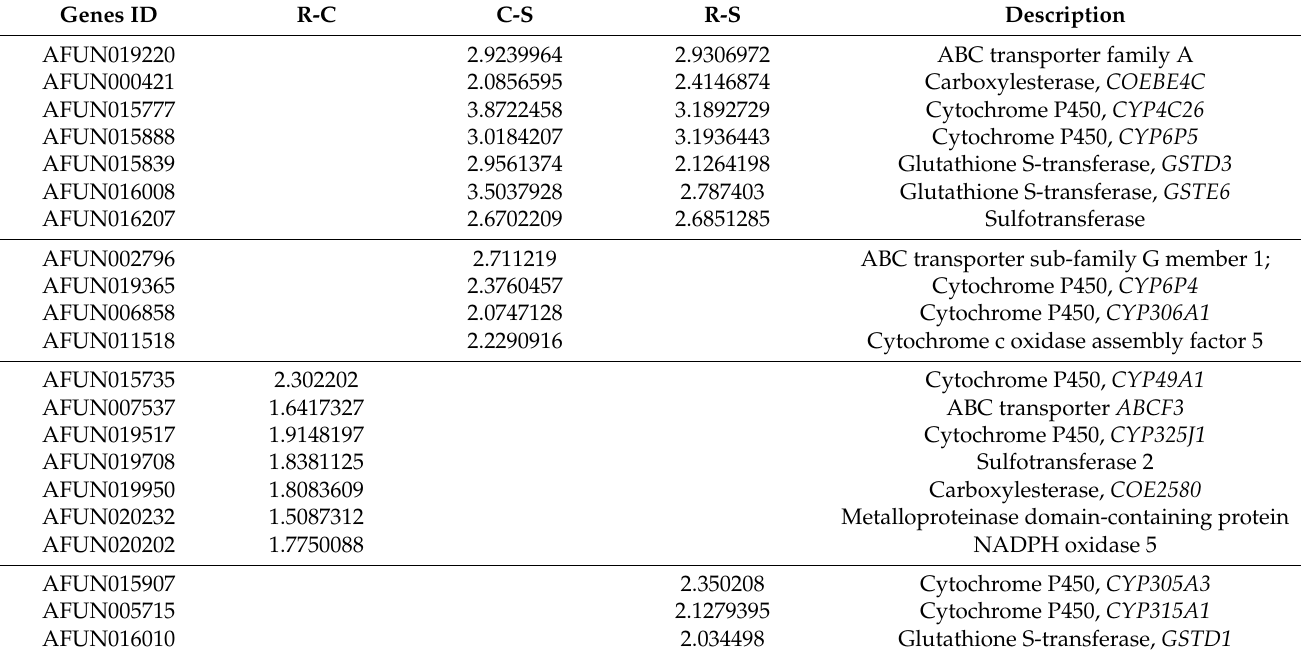
Table 4. Detoxification genes differentially expressed in Uganda between different comparisons at FDR < 0.05 and FC > 1.5 for R-C or FC > 2 for C-S and